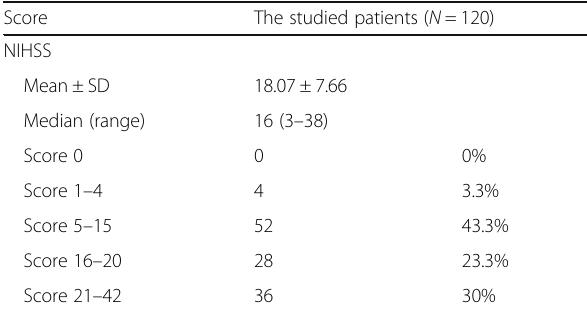
Table 1 NIHSS score categories among patients Score